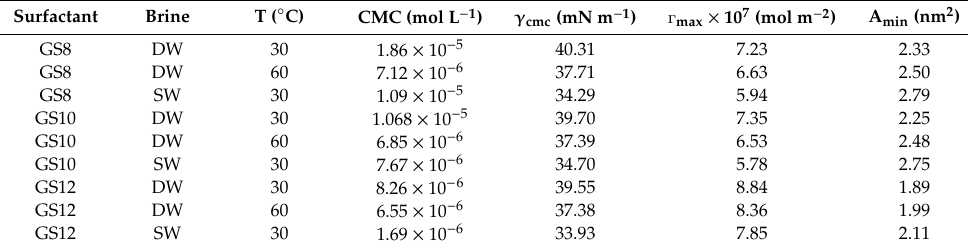
Figure 14. The surface tension of GS12 at different salinities and temperatures. Table 6. Surface properties of GS8, GS10 and GS12 at various temperatures and